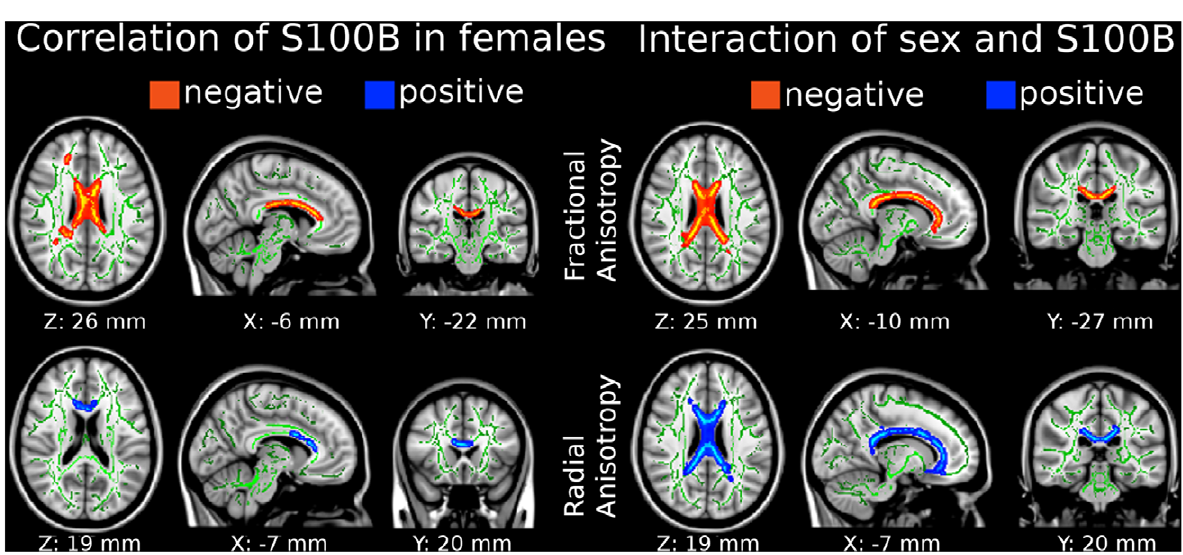
Figure 1. Diffusion tensor imaging parameters correlate with serum S100B mainly in the corpus callosum, anterior forceps, and the right superior longitudinal fasciculus of the female brain (left) in comparison with male brains (right). Clusters are corrected for multiple comparisons ( p , 0.05, threshold-free cluster enhancement), positions are reported in MNI-coordinates. There was no significant correlation of S100B in male brains alone using multiple comparison correction and very little using uncorrected thresholds (not shown). Radiological convention (left side of the brain is presented on the right).